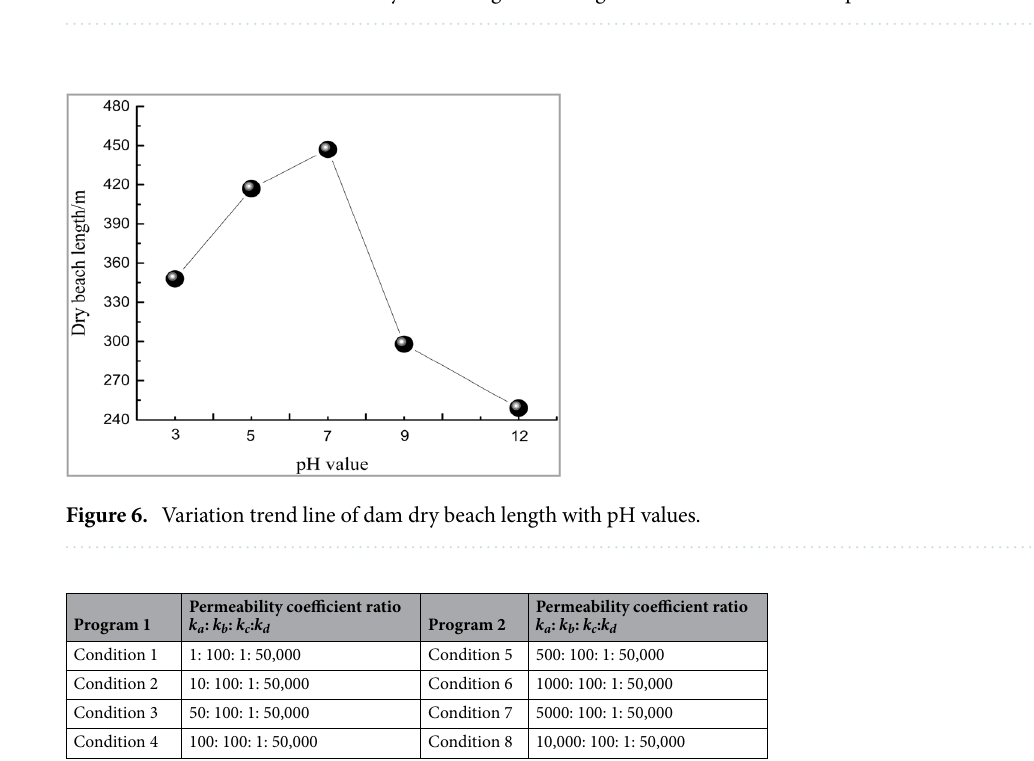
Table 4. Effective saturation and dry beach length of tailings reservoir under different pH values conditions.